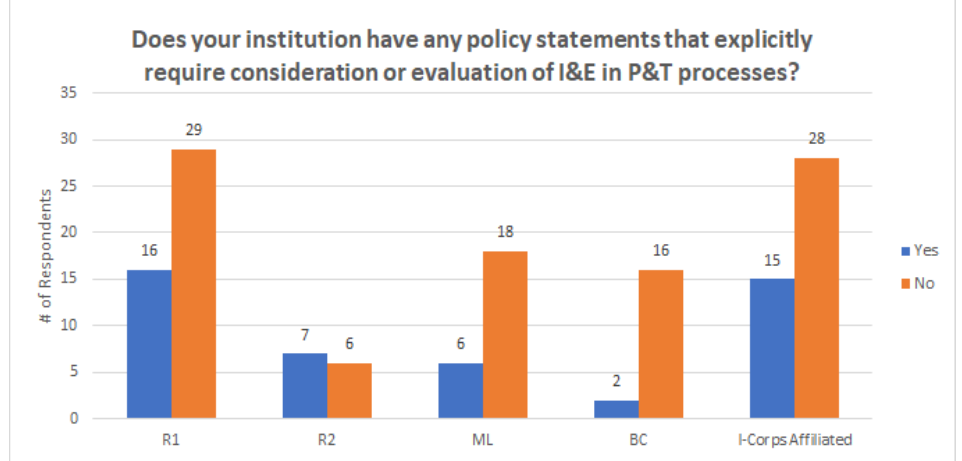
Figure 8. Comparison of institution type responses, including I-Corps affiliated institutions, on the existence of policy statements that require consideration or evaluation of I&E in P&T processes at their